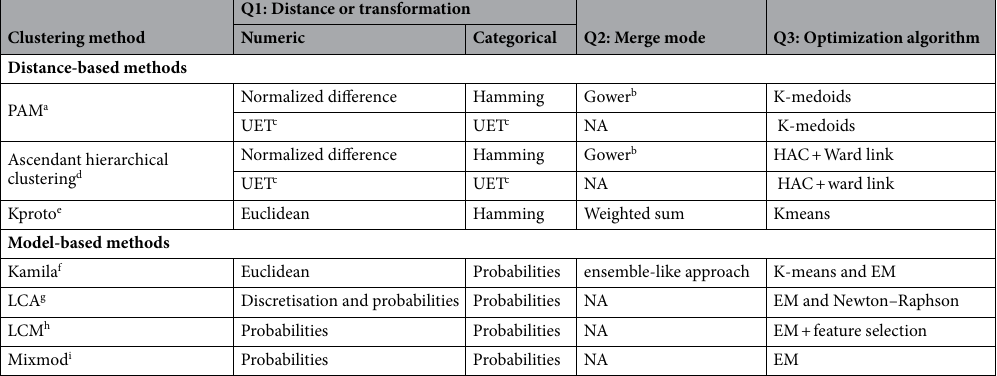
Table 1. Description of selected methods with regards to design questions related to (1) similarities/distances or data transformation, (2) methodology to merge numerical and categorical parts and (3) algorithm choice. NA, Not applicable; EM, Expectation Maximization ; PAM, Partitioning Around Medoids; HAC, Hierarchical Ascendant Clustering; UET, Unsupervised Extra Trees dissimilarity. a clustMixType package (PAM function): https ://cran.r-proje ct.org/web/packa ges/clust MixTy pe. b Cluster package (daisy function): https ://cran.r-proje ct.org/web/packa ges/clust er. c Yet unpublished UET package, available at https ://gitla b.inria .fr/kdall eau/uetcp p, build_randomized_tree_and_get_sim function. d Stats (R-base package, hclust function): https ://stat.ethz. ch/R-manua l//R-devel /libra ry/stats /html/00Ind ex.html. e clustMixType package (kproto function); see a . f Kamila package (kamila function): https ://cran.r-proje ct.org/web/packa ges/kamil a. g poLCA package (poLCA function): https ://cran.r-proje ct.org/web/packa ges/poLCA . h VarSelLCM package (VarSelCluster